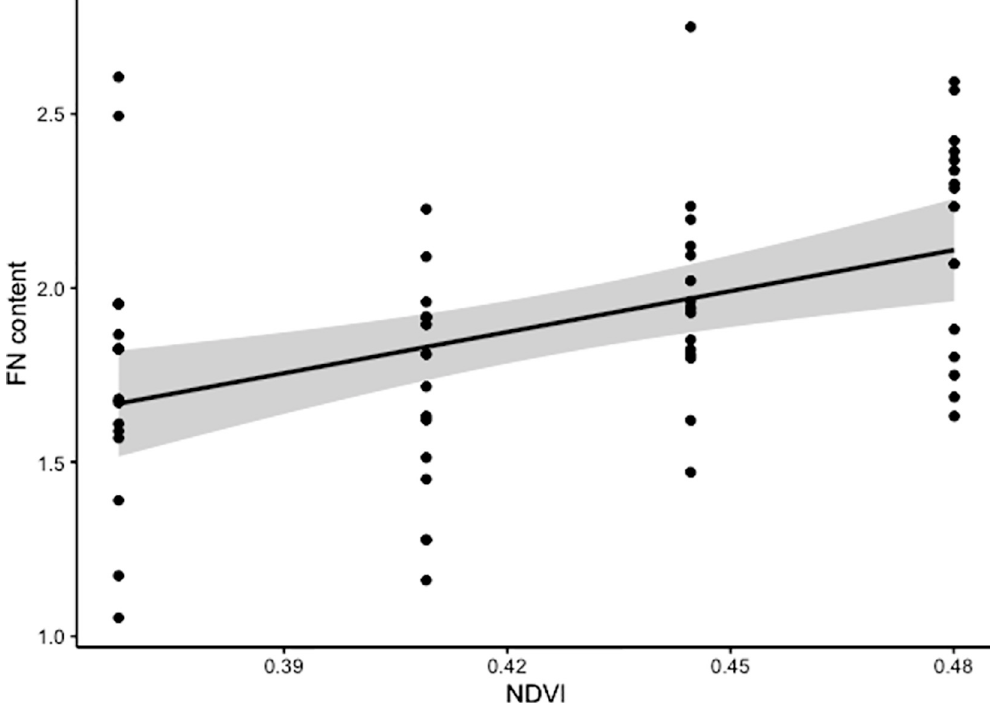
Fig 1. Relationship between mean NDVI in spring-summer and FN content during the rut, from model 1. Line represents model prediction when all other variables are set to their mean values. Points are raw observed data. Shaded areas denote 95% confidence